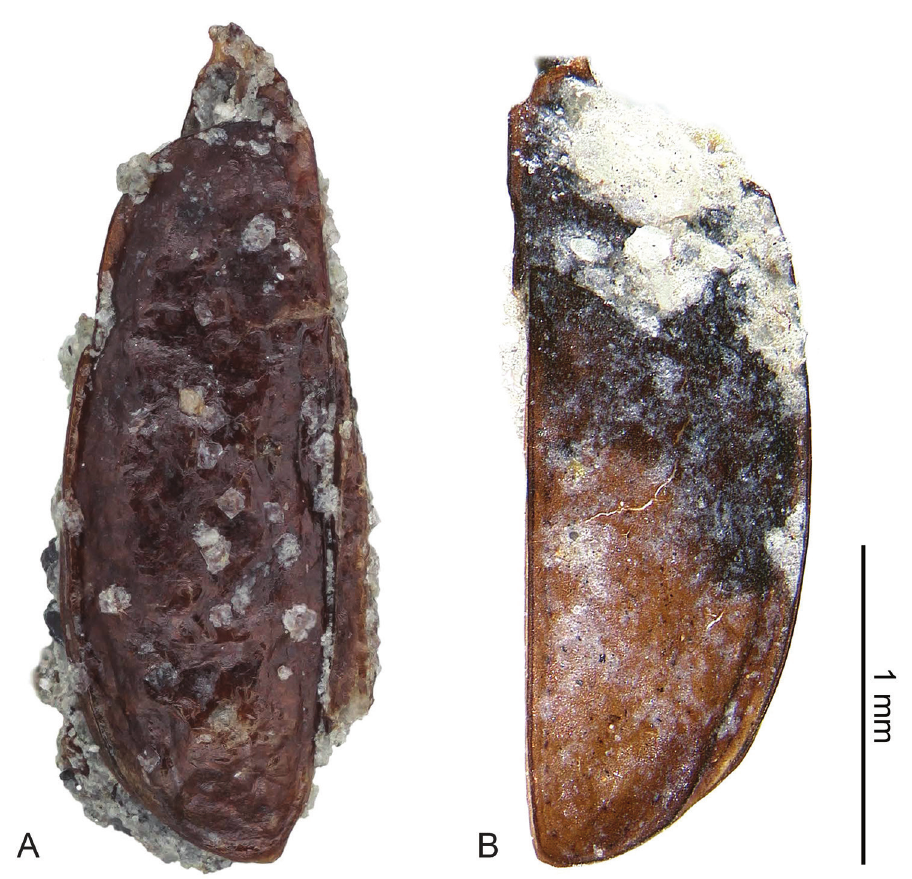
Figure 5. Fossils of the left and right elytra of A. balli sp. n. A The left elytron, 2.36 mm in length, is designated as the paratype (USNM: ADP147732). A small part of the right elytron of the same individual is attached along the suture near the apex. The siltstone matrix is visible along the outer margin near the apex. The small rhomb-shaped crystals on the surface are authigenic calcite B The right elytron is desig- nated as the holotype. (NMNH: ADP147741). The elytron is 2.40 mm in length. The base is deformed by a crack and concealed by sediment grains. A small part of the left elytron of the same individual is still attached along the suture near the